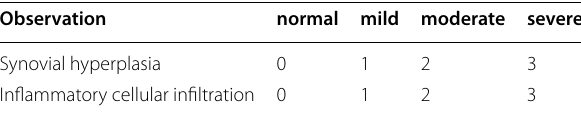
Table 2 The histology sections of joints were qualitatively assessed for various histopathology features scoring from 0 to 3, as follows